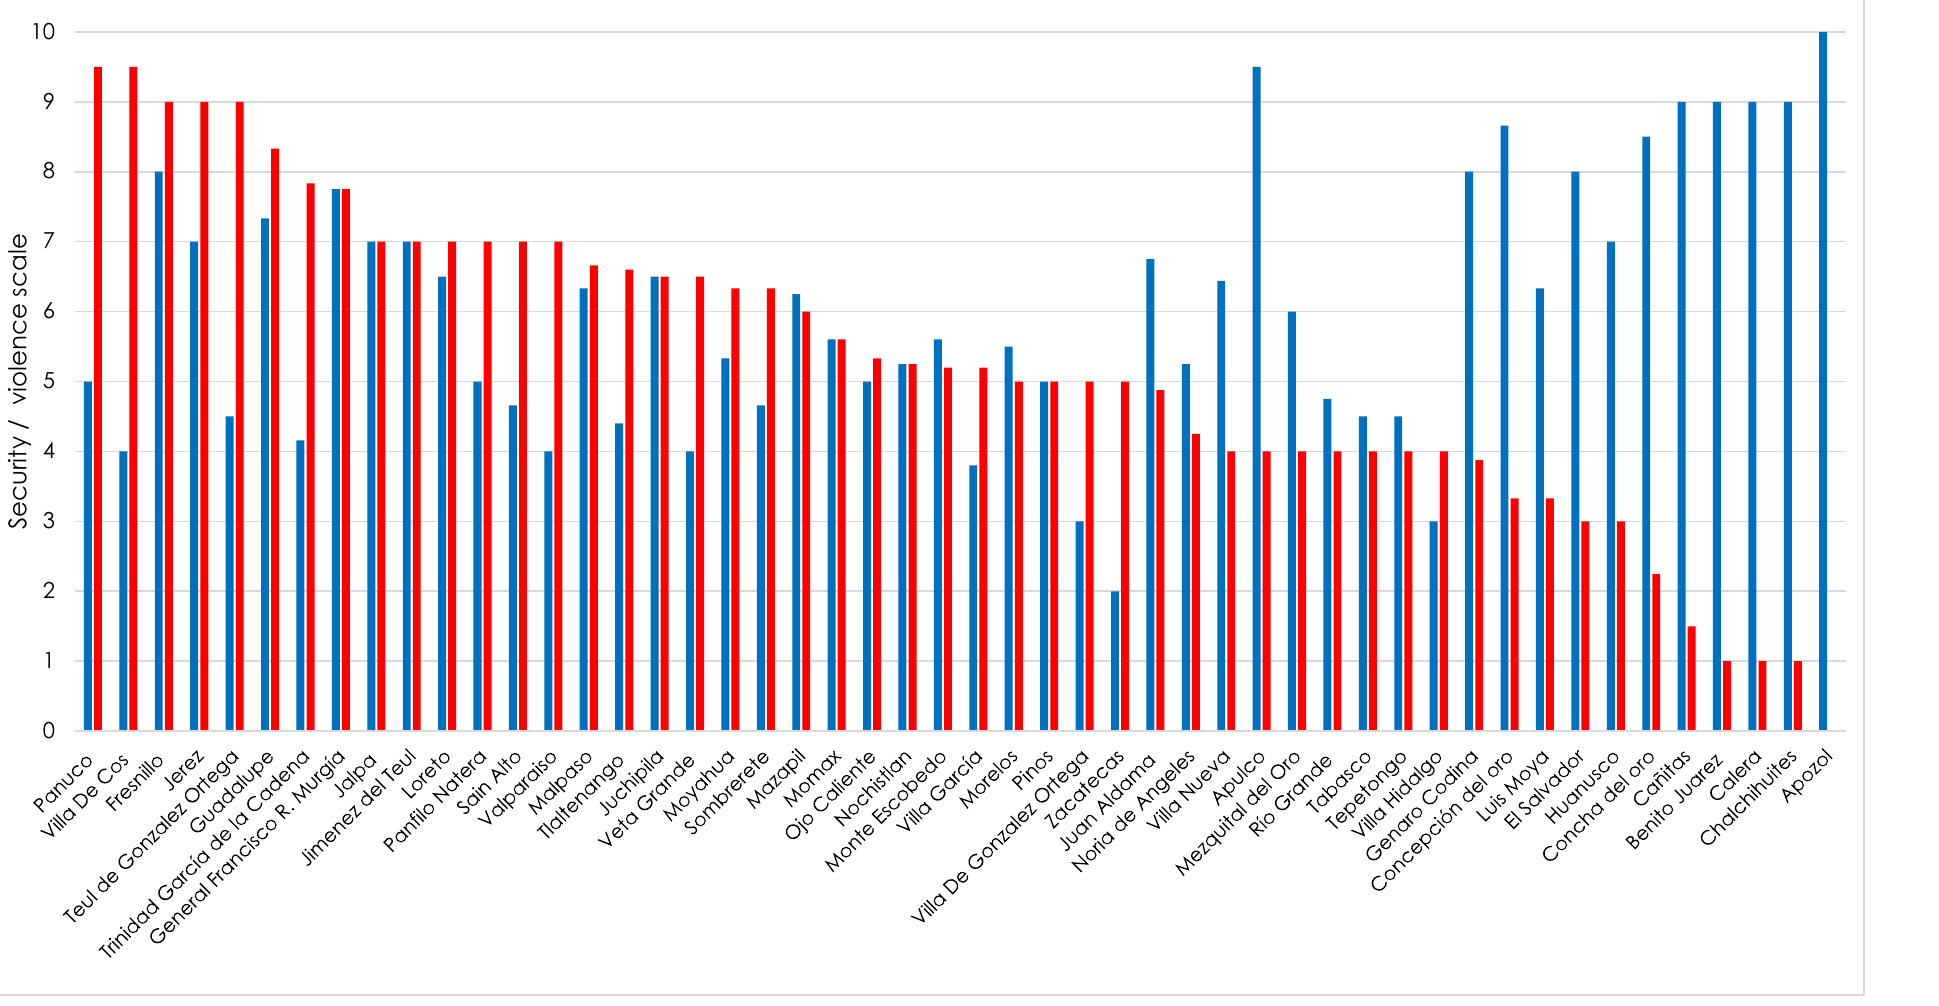
Figure 5. Levels of security and violence perceived by SSMIs of the State of Zacatecas of the 2020–2021 Class in the locality where they did their social service work. Plot was constructed without distinguishing by sex the study population. Security level: blue bars. Violence level: red bars.